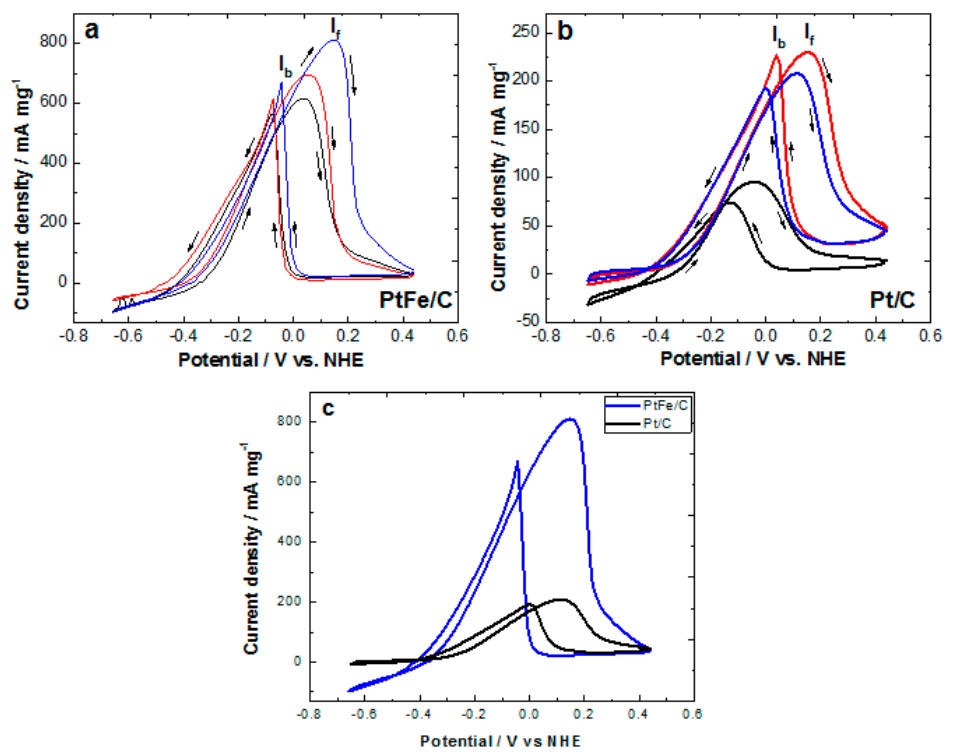
Figure 6. Cyclic voltammograms for ( a ) PtFe/C and ( b ) Pt/C as function of the ethanol concentration. 0.1 M, 0.5 M and 1 M ethanol are illustrated in black, red and blue lines, respectively; ( c ) Comparison of the activities with 1 M ethanol. Scan rate: 20 mV·s − 1 .